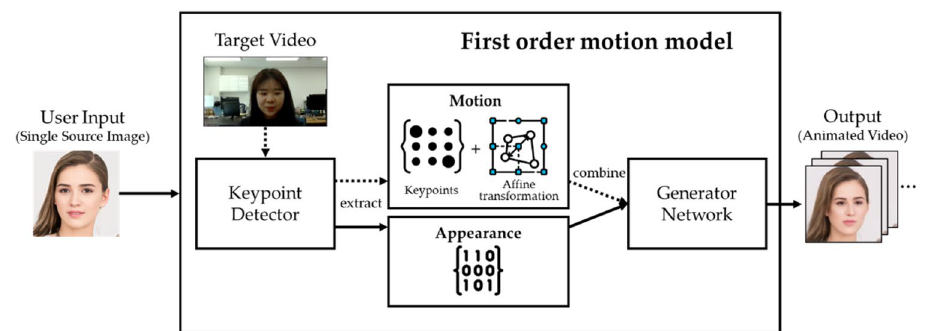
Figure 3. The first order model 34 in our evaluation